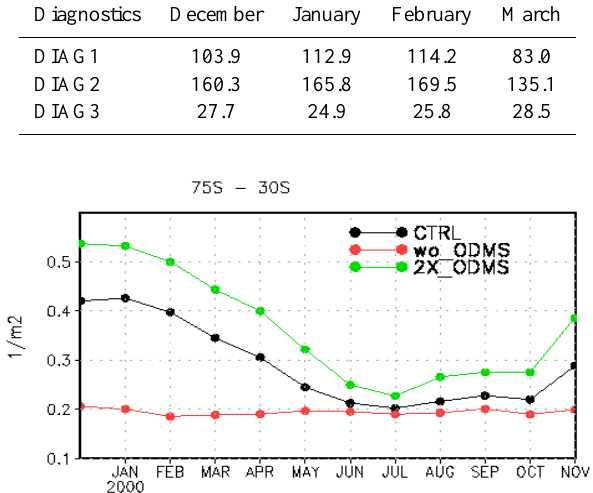
Fig. 2. Latitudinally averaged (30 ◦ S–75 ◦ S) time series (December 1999–November 1999) of the vertically integrated CDNC (1 m − 2 ) shown as absolute values in (a) CTRL simulation denoted by the black line (b) wo ODMS simulation denoted by the red line and (c) 2X ODMS simulation denoted by the green line. The variables are multiplied by 10 − 11 .